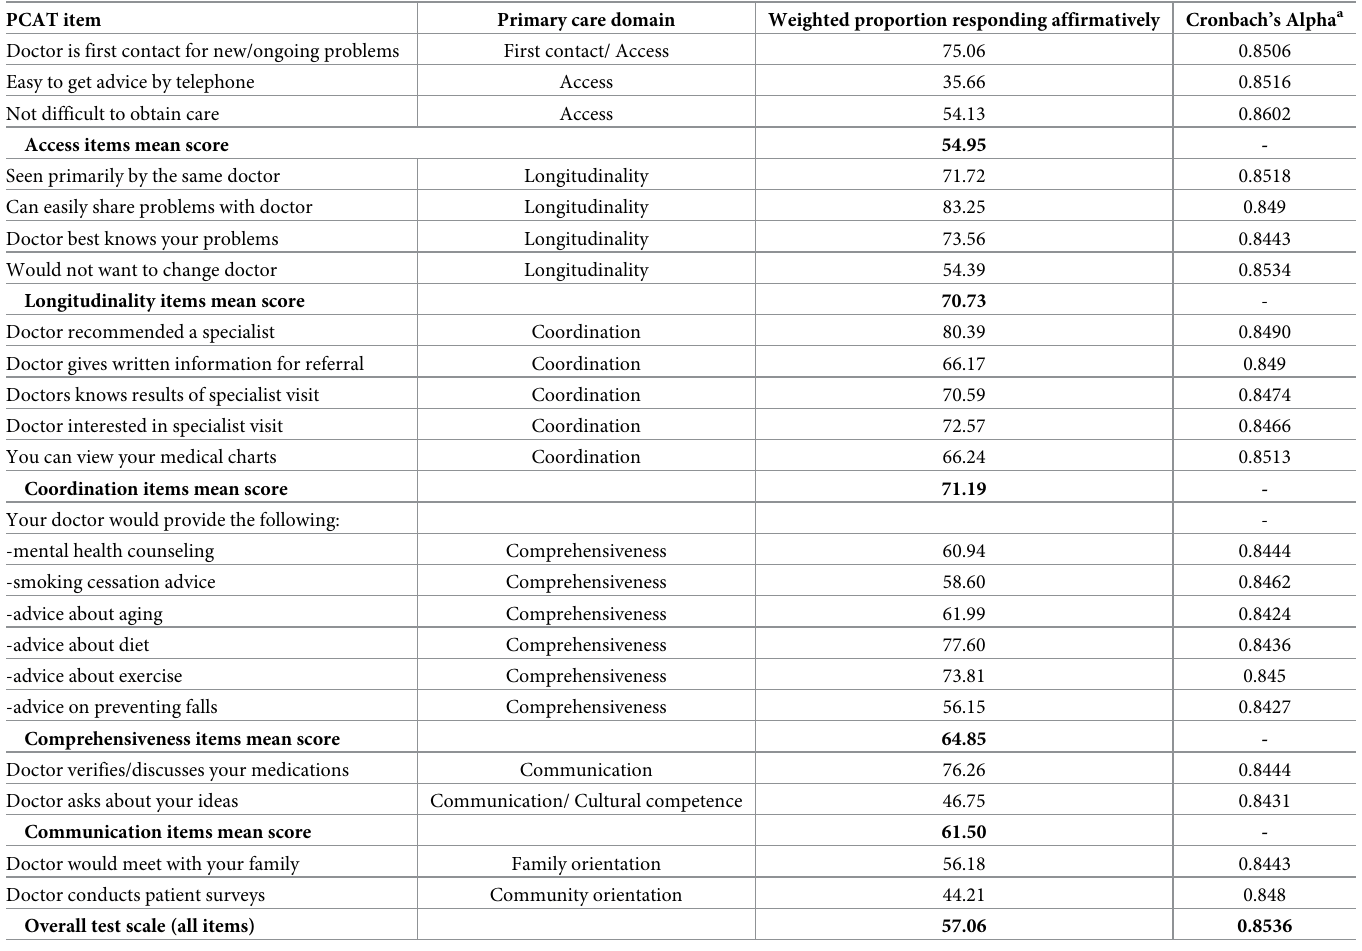
Table 1. Specific PCAT items, corresponding primary care domain, and Cronbach alpha